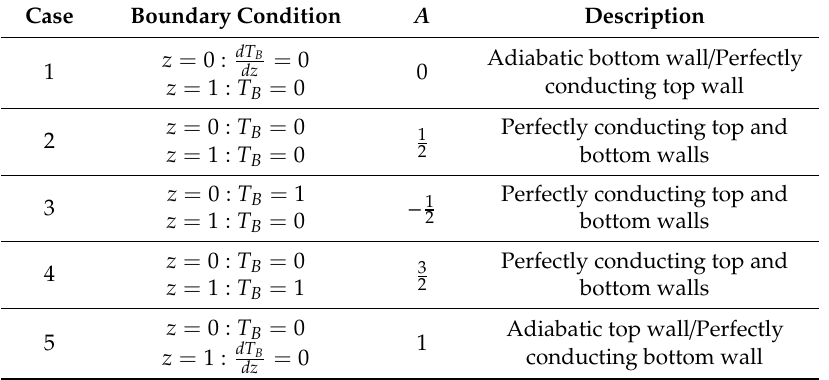
Figure 1. Illustration of vibrating porous layer with thermal boundary conditions shown in Table 1.